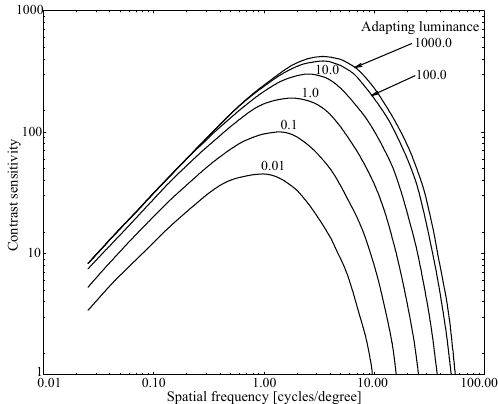
Figure 3. Luminance contrast sensitivity function (CSF) predicted by Barten’s model (Equations (1)–(3)) for stimulus of size 10 degree and different means.